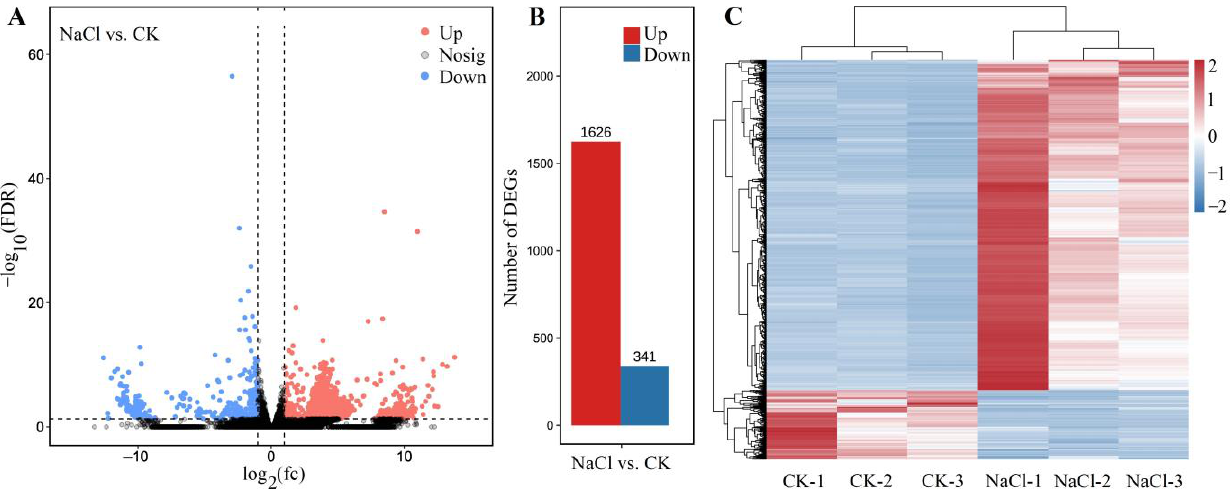
Figure 4. Volcano plot of unigenes ( A ), number of DEGs ( B ), and cluster heat map of the DEGs ( C ) for NaCl (300 mmol/L) vs. CK. The black represent the genes without difference changes in the criteria of the false discovery rate (FDR) < 0.05 and |log2(fold-change)| > 1.